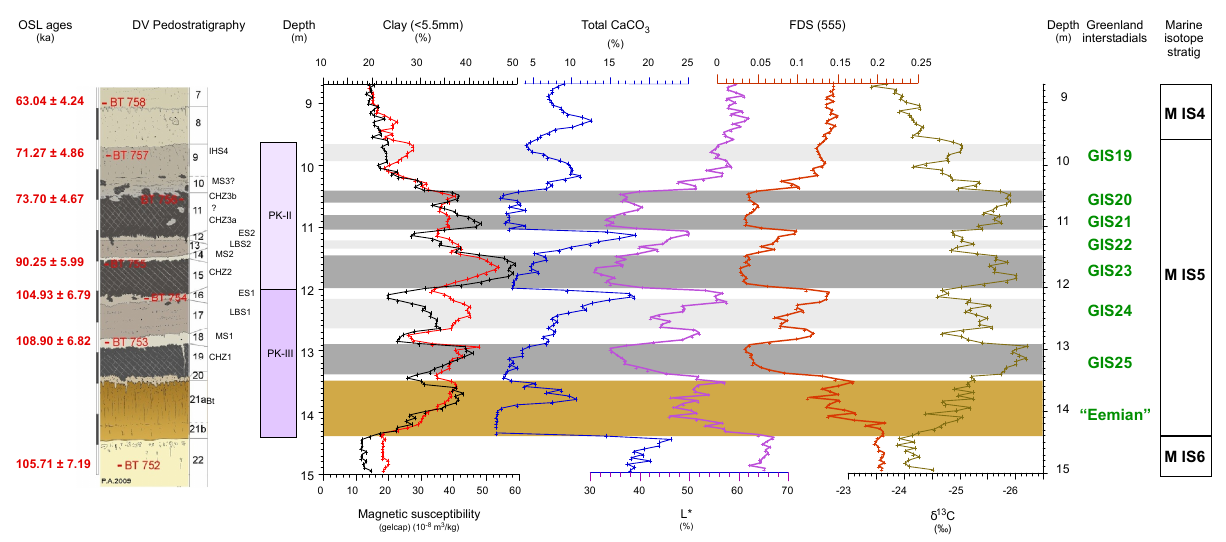
Fig. 5. Continuous, quantitative characterization of the DV soil complexes. On the left are OSL ages (mean ± error) and the DV pedos- tratigraphy. In the middle panel, from left to right: clay content (%), black curve; low-frequency magnetic susceptibility (10 − 8 m 3 kg − 1 ) , red curve; total carbonate content (%), blue curve; two spectrometric parameters – sediment brightness L ∗ (%), purple curve, and first- derivative spectrum FDS, red curve; and, finally, δ 13 C from organic matter, yellow curve. The FDS plotted here corresponds to the 555-nm band characteristic of iron hydroxides such as goethite (cf. Debret et al., 2011). On the right are the proposed correlations with Greenland interstadials and marine isotope stratigraphy. Eolian events (MS and ES) are clearly individualized, as are chernozems (CHZ – IHS) and “Lehmbröckelsände” (LBS – or pellet